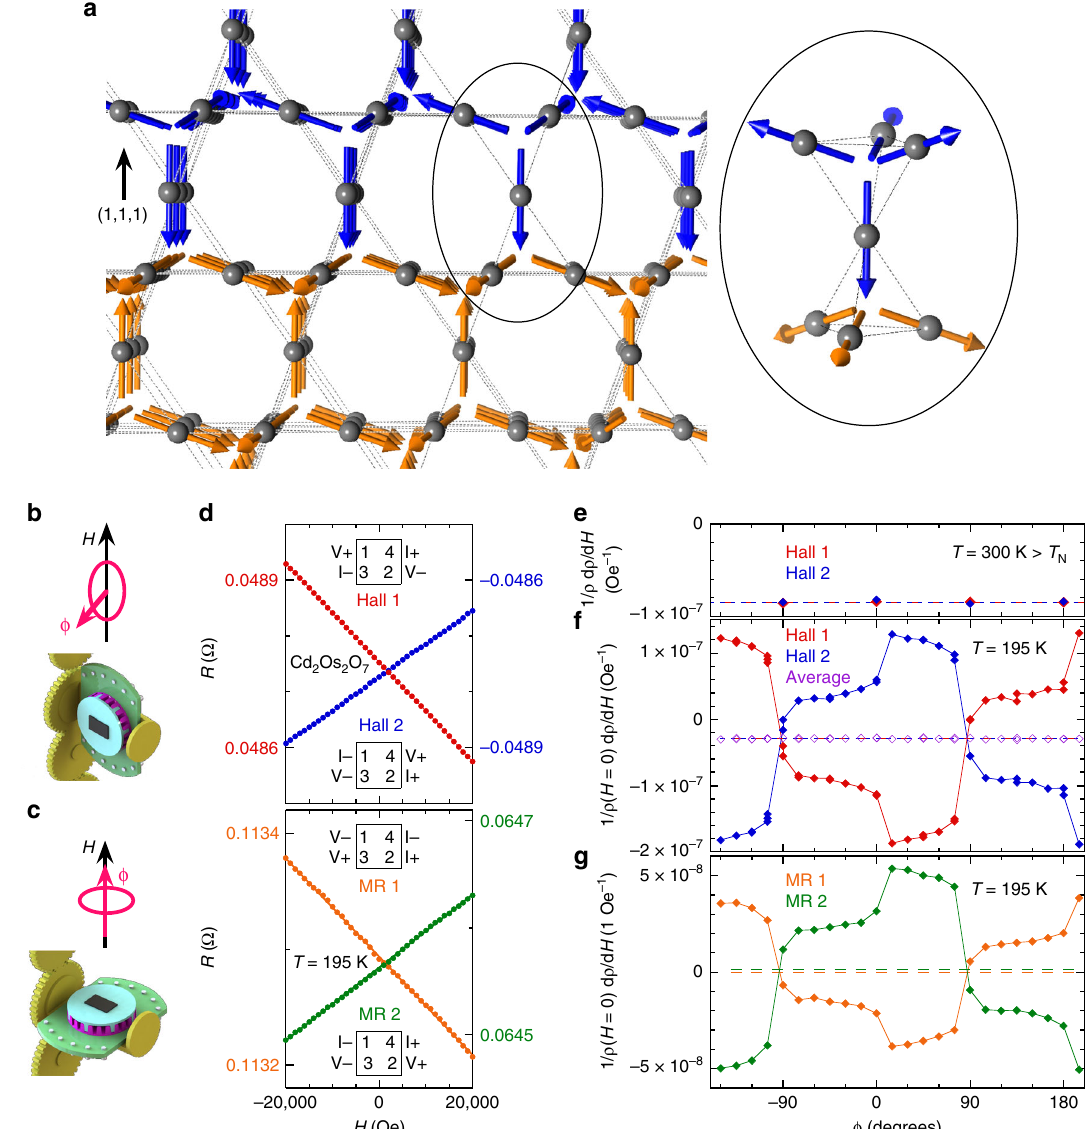
Fig. 3 Antisymmetric linear magnetoresistance from ferromagnetic domain walls. a A schematic view of the domain boundary along the (1, 1, 1) plane of Cd 2 Os 2 O 7 . While the top (blue) and bottom (orange) spins make up two bulk all-in-all-out (AIAO) antiferromagnetic domains, the domain wall can be seen in this simple representation as the interfacial layer made up of individual tetrahedra with a one(blue)-in/three(orange)-out spin con fi guration with ferromagnetic projections perpendicular to the (1, 1, 1) plane. The inset provides a detailed three-dimensional perspective at the domain boundary. In real materials, a magnetic domain wall would form over a fi nite distance with spins gradually rotating in space, as exempli fi ed by the three-in to three-out domain wall in a two-dimensional Kagome lattice 30 . b , c Schematics of a two-rotator setup, including both a motorized continuous horizontal rotator, and a 3D-printed 15-degree-increment indexing stage. A plate-shaped sample was cooled through T N with a fi eld-in-plane con fi guration ( b ), before it is fl ipped 90° to have the measurement fi eld perpendicular to the surface at low temperature ( c ). The index stage sets the direction of the in-plane fi eld cooling and magnetization. d Representative antisymmetric linear galvanomagnetic curves from two reciprocal Hall con fi gurations and two independent vdP MR channels. Insets mark the lead con fi guration of each measurement. e – g Normalized linear slopes 1/ ρ ( H = 0) d ρ /d H as a function of in-plane M rotation angle ϕ for two Hall con fi gurations, both above ( T = 300 K) and below ( T = 195 K) T N = 227 K, and two vdP MR channels at 195 K. The ϕ -averaged slopes for each of four channels are marked by dashed lines of the same color. The average values of two slopes of reciprocal Hall channels at T = 195 K are also plotted (purple diamonds) against ϕ , showing no angular dependence. All error bars are smaller than